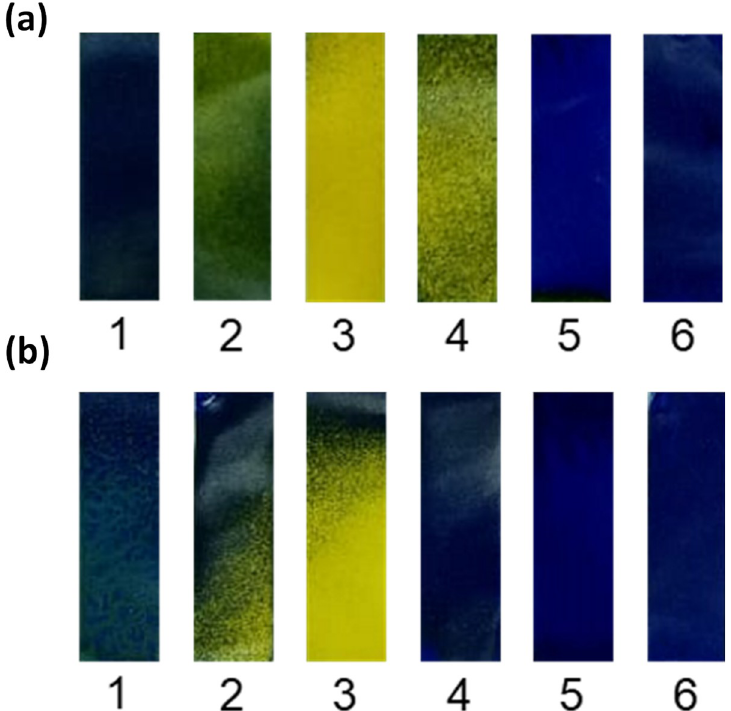
Fig 5. Discoloration of the WSPs exposed to spraying of the biocidal agent in the disinfection chamber in the study areas: (a) WSPs collected after 10 s of exposure; (b) WSPs collected after 30 s of exposure. WSPs position: (1) cap; (2) safety glasses; (3) respirator face mask; (4) lab coat; (5) glove; and (6) shoe. Blue areas represent the deposition of the biocidal agent, while yellow areas indicate no